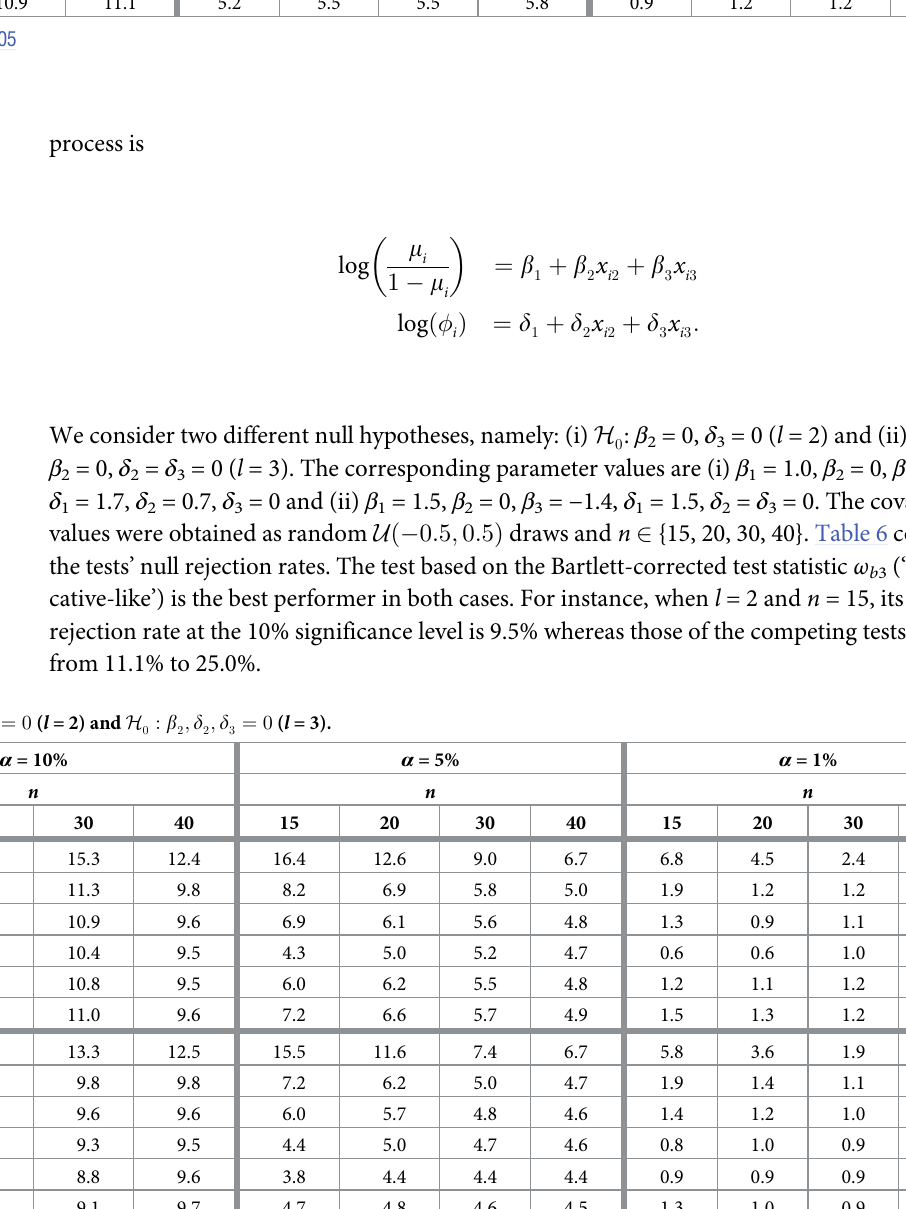
Table 5. Null rejection rates (%), H